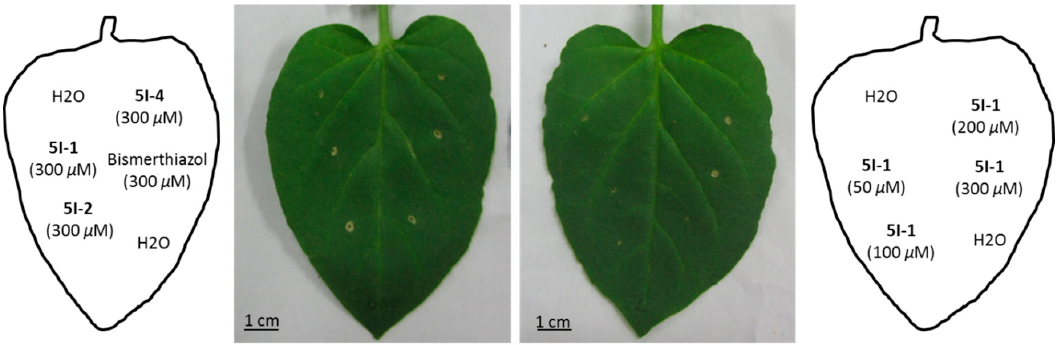
Figure 3. Phytotoxicity assay on tobacco plant representative examples of tobacco leaves four days after inoculation.